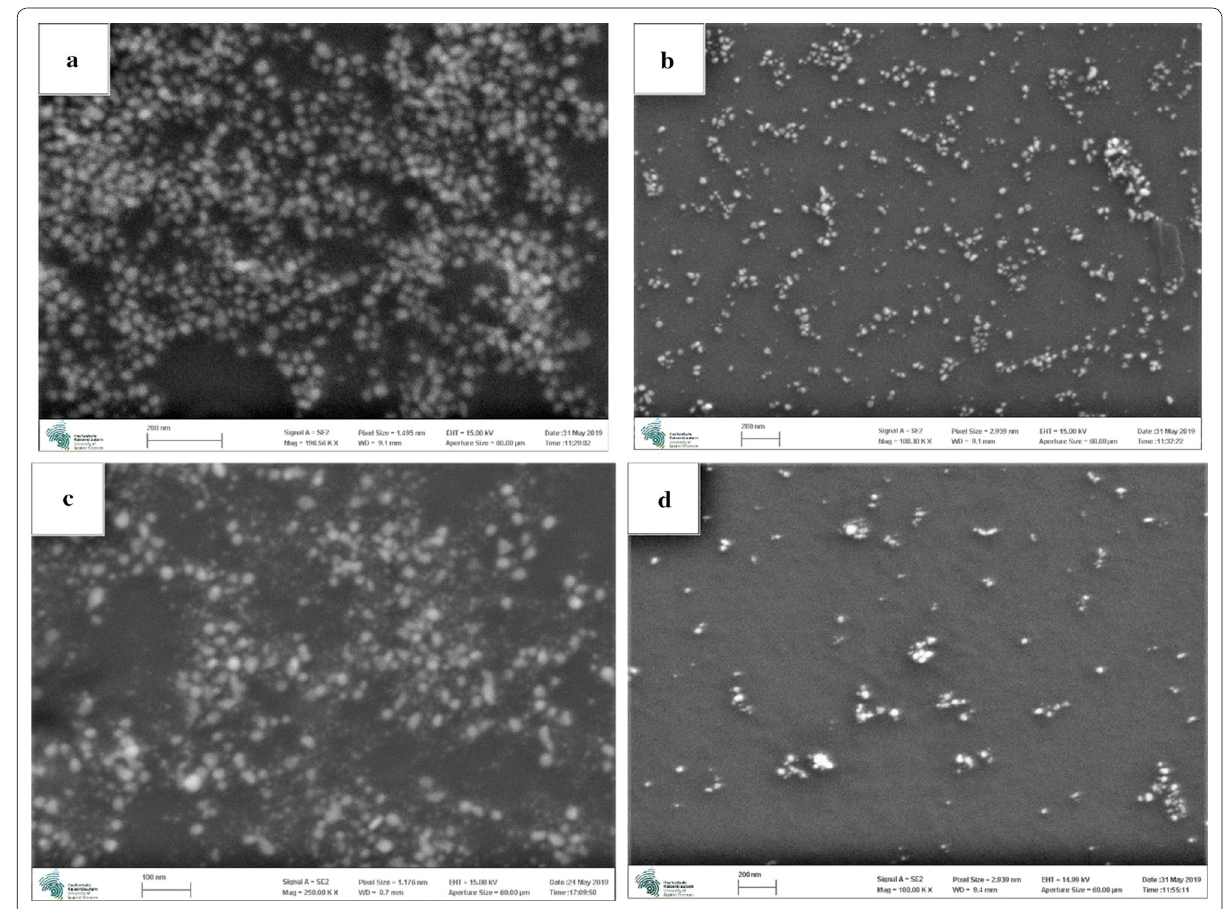
Fig. 5 SEM analysis of Ag NPs: Ag NPs 1 ( a ), Ag NPs 2 ( b ), Ag NPs 3 ( c ), Ag NPs 4 ( d ). See the